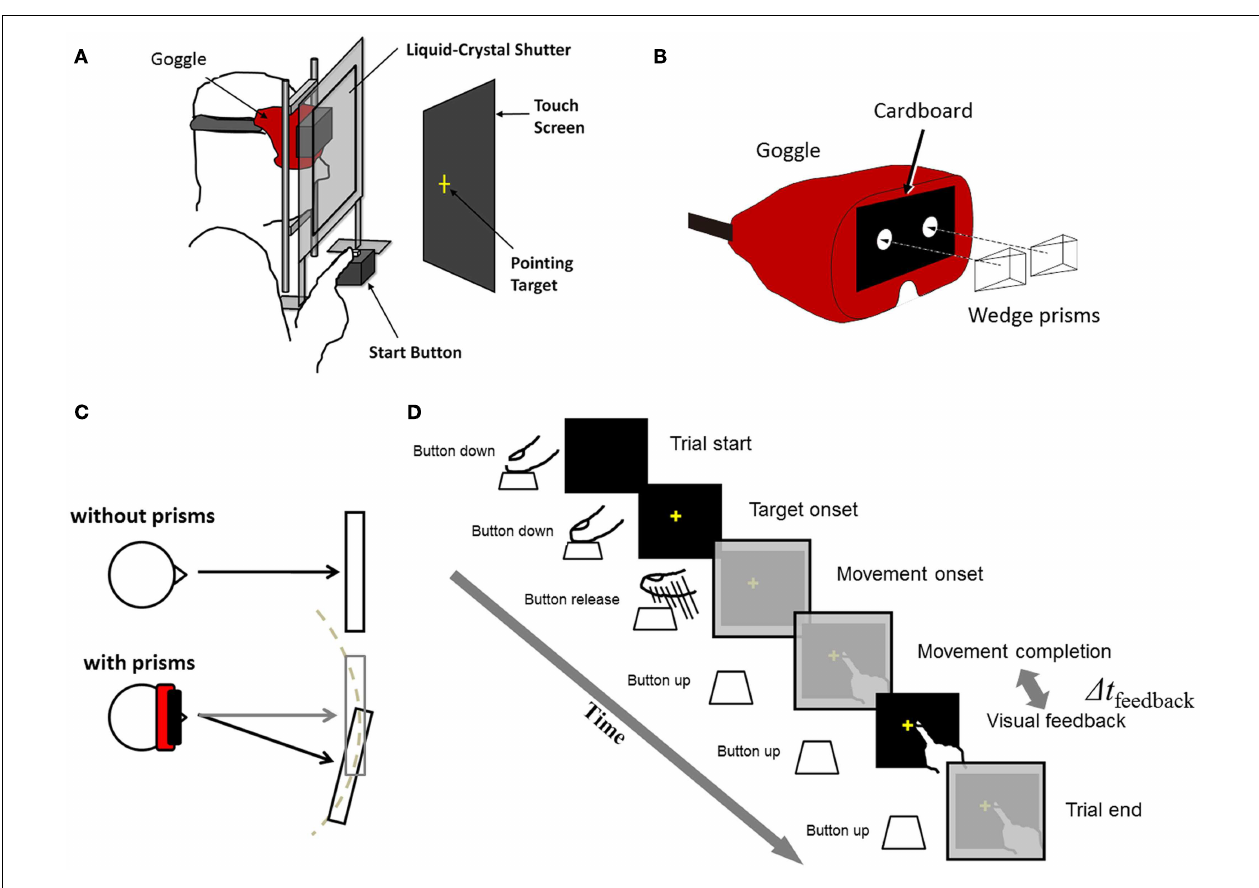
adjusted so that the target location and the visual feedback fall within the central visual field. (D) Time flow of a single trial. ∆ t feedback is the interval from movement completion to visual feedback and is adjusted in various